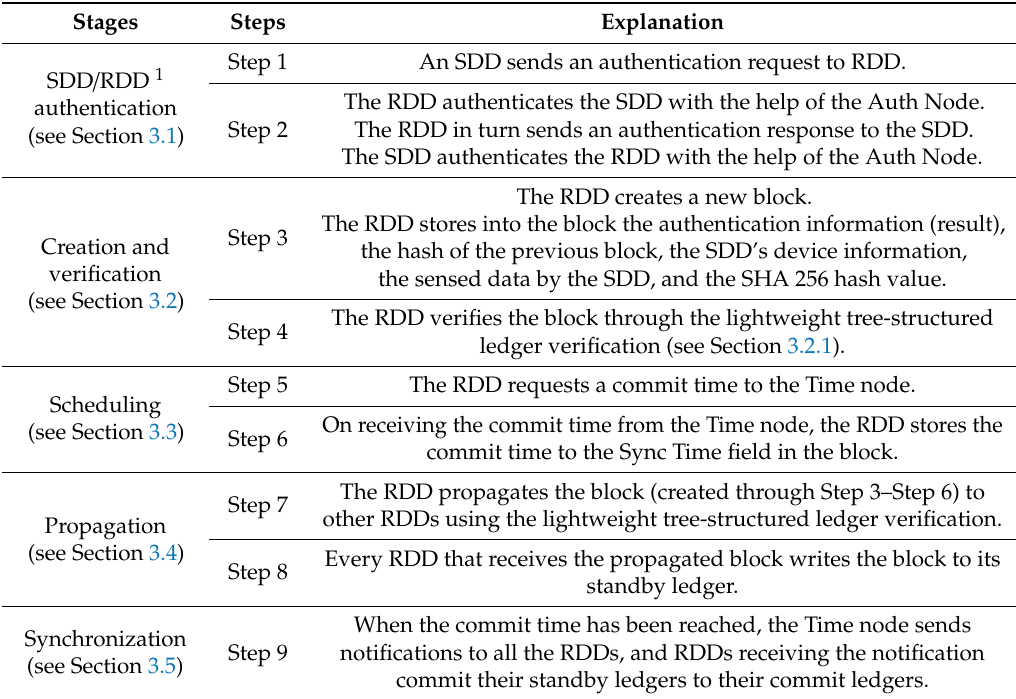
Table 3. The algorithm of the authentication and block chaining process using the proposed lightweight